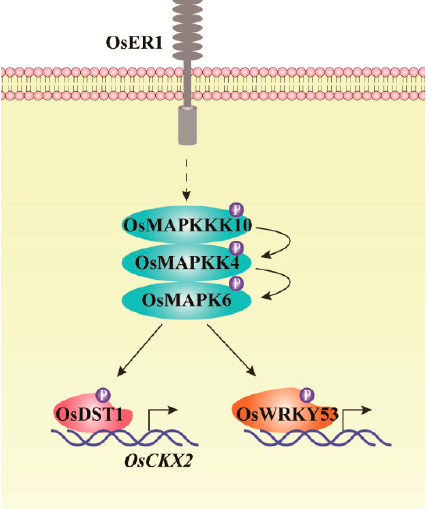
Figure 1. Schematic diagram of MAPK cascade regulating rice panicle and grain develop- ment. Plasma membrane localized receptor kinase OsER1 acts directly upstream of Os- MAPKKK10-OsMAPKK4-OsMAPK6 cascade. The phosphorylated OsMAPK6 can phos- phorylate OsDST1, then the phosphorylated OsDST1 targets and promotes the transcrip- tion of OsCKX2 , regulating rice panicle morphology. Simultaneously, OsMAPKKK10-Os- MAPKK4-OsMAPK6 cascade can phosphorylate OsWRKY53 to regulate rice BR signal transduction to alter rice architecture